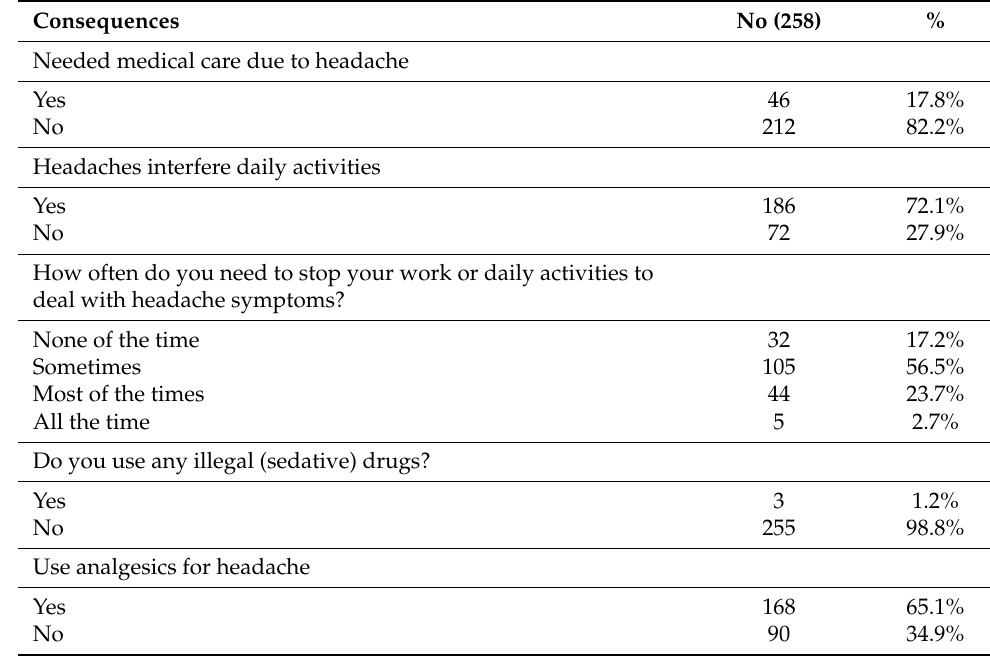
Table 5. Distribution of study sample based on attitudes, behavior, and